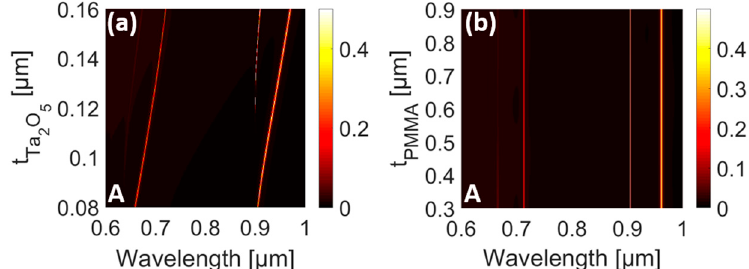
Figure 6. ( a ) Absorption map with respect to the variation of Ta 2 O 5 layer thickness t Ta2O5 under TE at normal illumination when the period, p, and PMMA pillar height, t PMMA, are fixed at 600 nm and 600 nm, respectively. ( b ) Absorption map under TE normal illumination, when PMMA pillar thickness t PMMA is varied from 300 nm to 900 nm. The period, p, and waveguide, Ta 2 O 5, thickness t Ta2O5 are fixed at 600 nm and 150 nm, respectively.